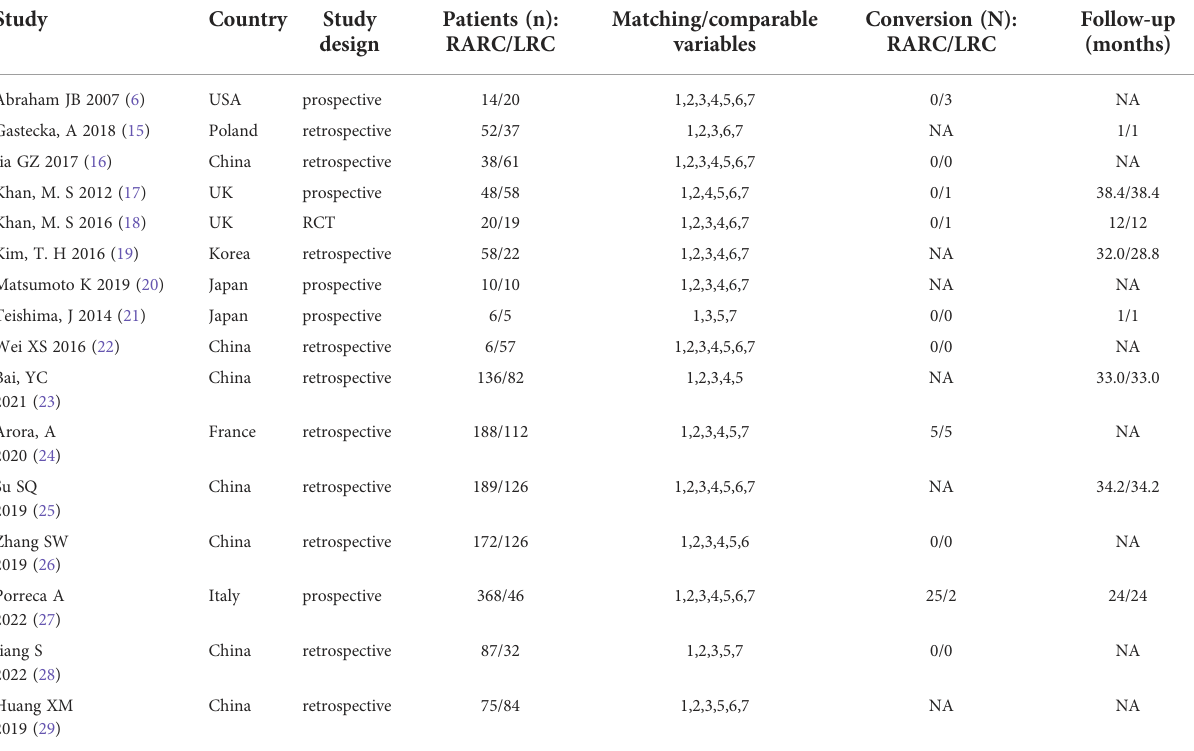
TABLE 1 The basic characteristics description of included studies.